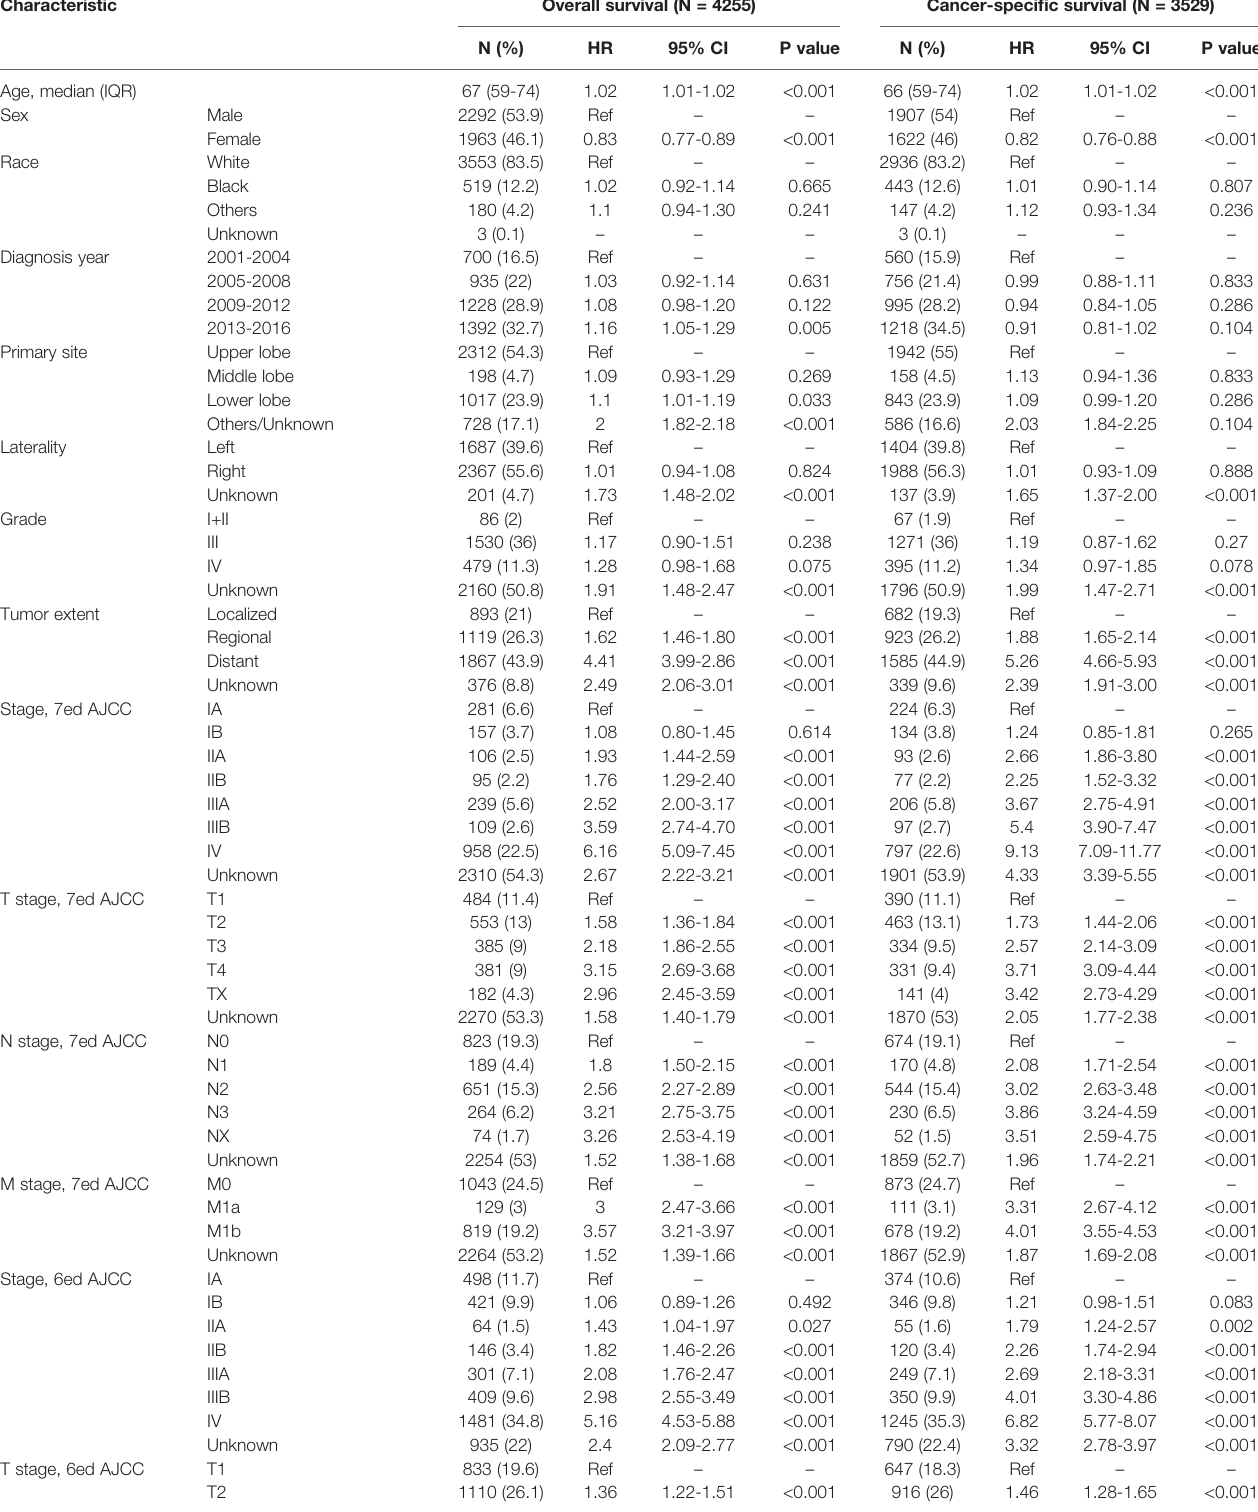
TABLE 3 | Univariate Cox regression analyses for patients with pulmonary large cell neuroendocrine carcinoma using SEER 18 Regs Custom Data (with additional treatment fi elds; November 2018 Submitted).